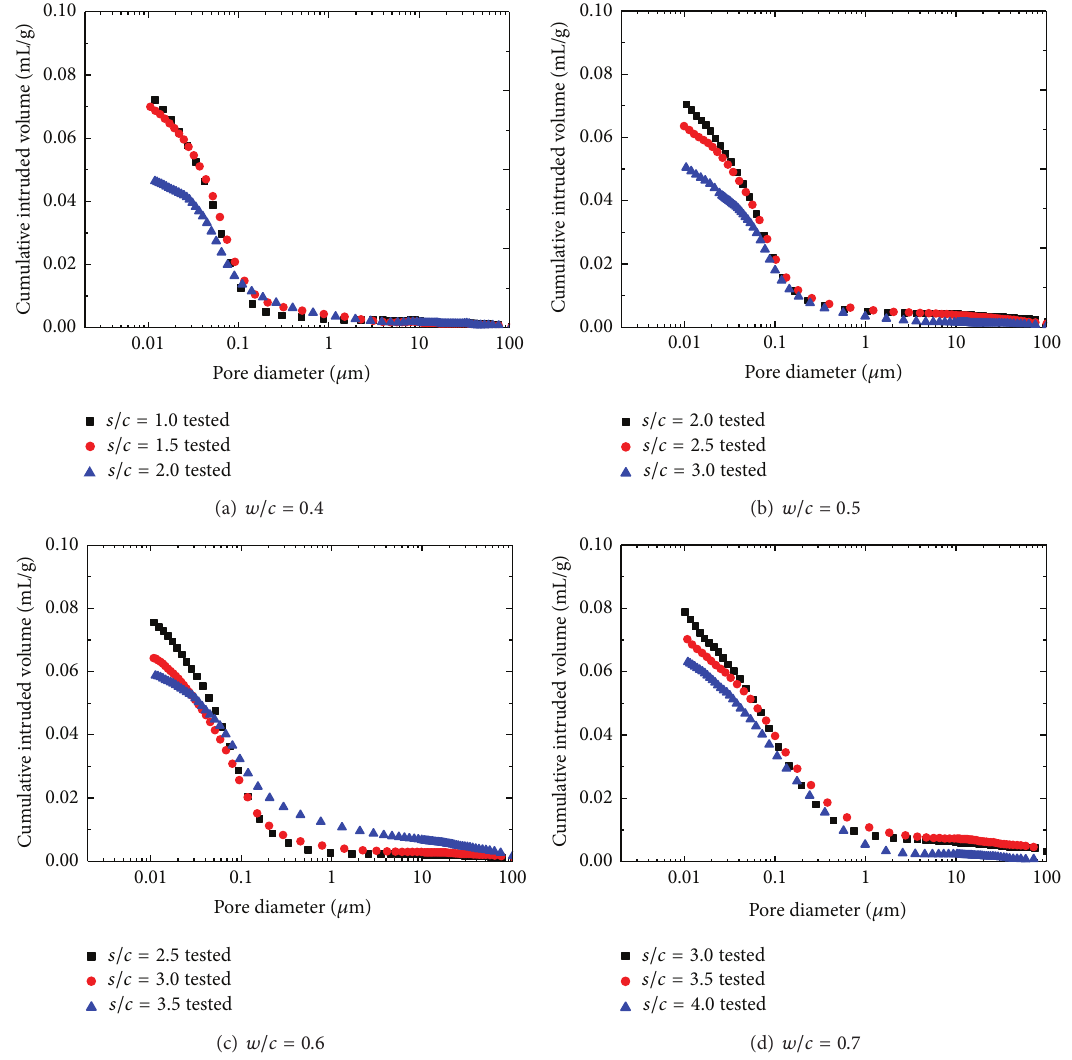
Figure 2: Cumulative intruded pore volume versus pore diameter for MS